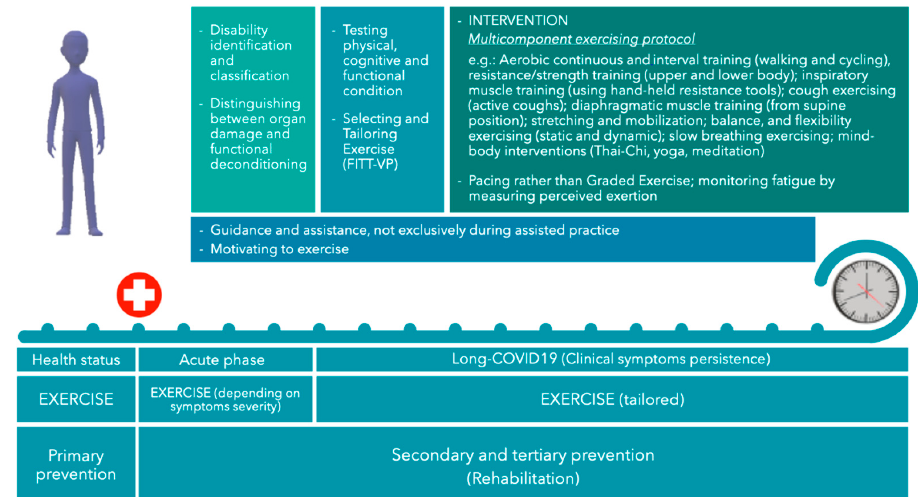
Figure 4. Exercise intervention with long COVID-19 patients. FITT-VP = frequency, intensity, time, type, volume, and progression.